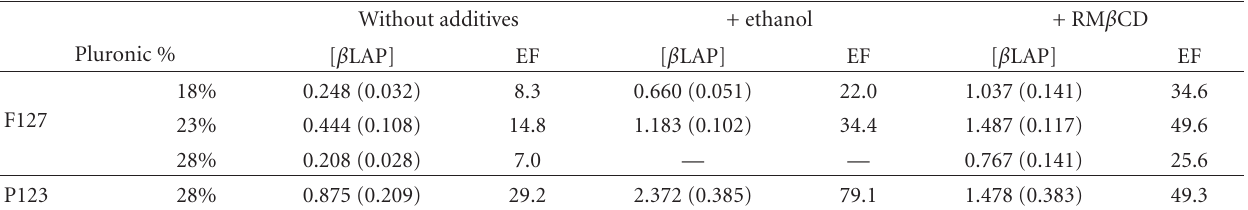
Table 3: β LAP solubility (mg · mL − 1 ) and enhancement factor (EF) in F127 and in P123 systems at 4 ◦ C with and without 5% (w/v) RM β CD and 20% (v/v) ethanol: mean values and, in parenthesis, the standard